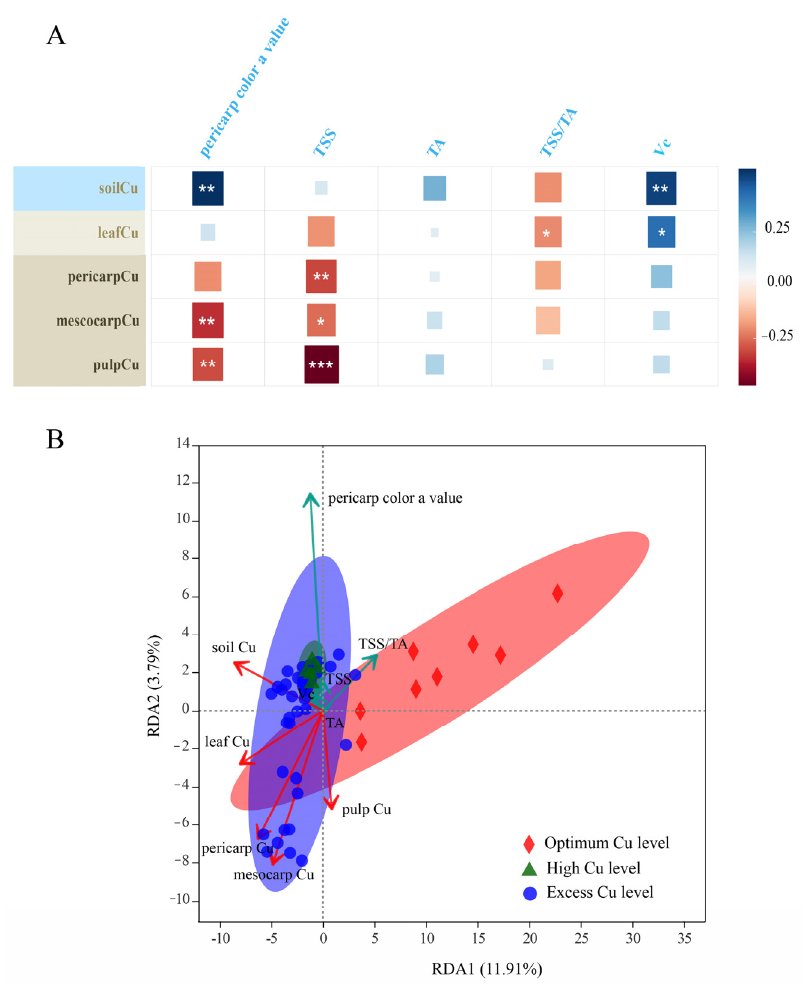
Figure 4. Correlation analysis ( A ) and redundancy analysis of soil-plant Cu versus fruit quality ( B ). * presented for p < 0.05, ** presented for p < 0.01, *** presented for p < 0.01, respectively.